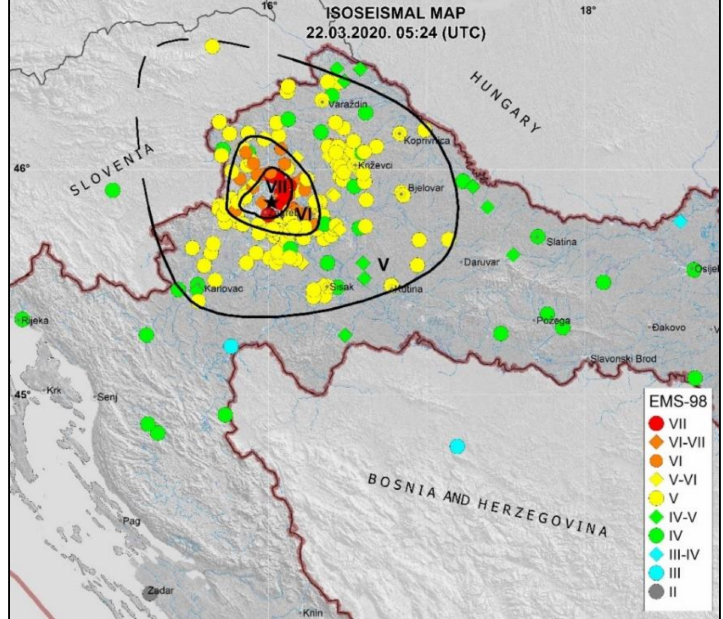
Figure 8. A preliminary intensity map of the M5.5 earthquake of 22 March 2020 at 5:24 AM (UTC). The epicentre is 7 km north of Zagreb city centre and is marked with a black